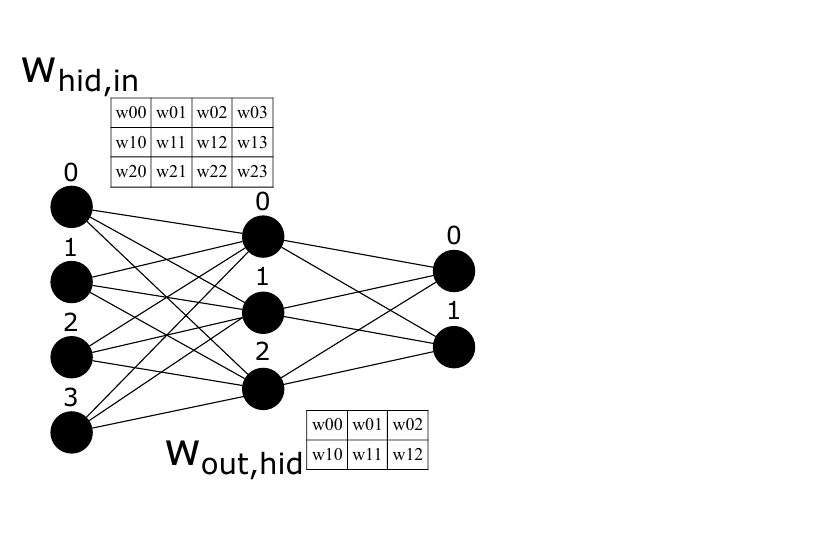
Figure 1. Simple MLP with 4 inputs, 3 hidden neurons, and 2 outputs and its weight